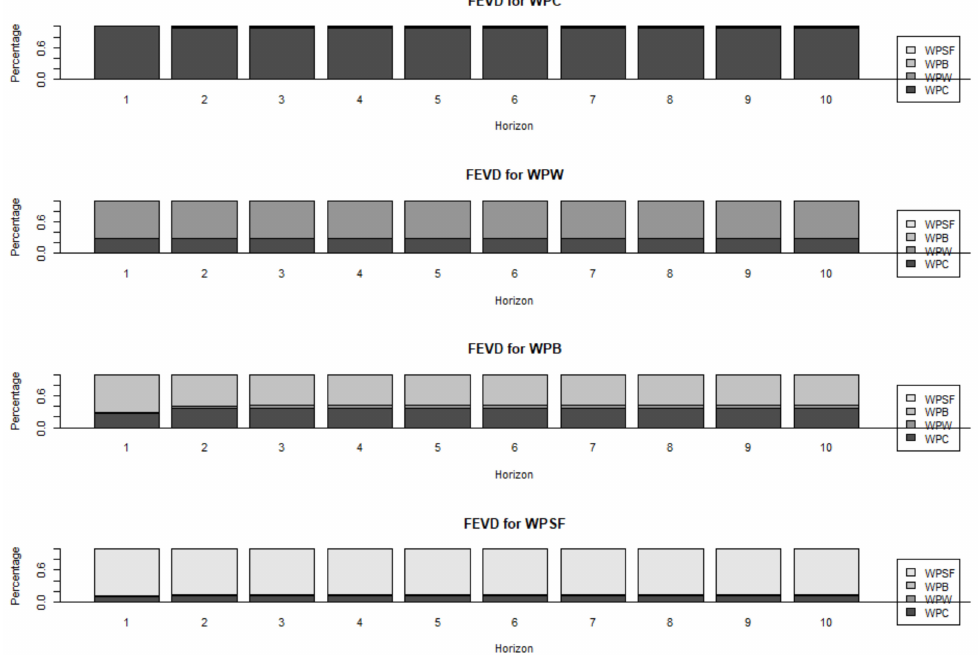
Figure 3. FEVD results for 10 periods